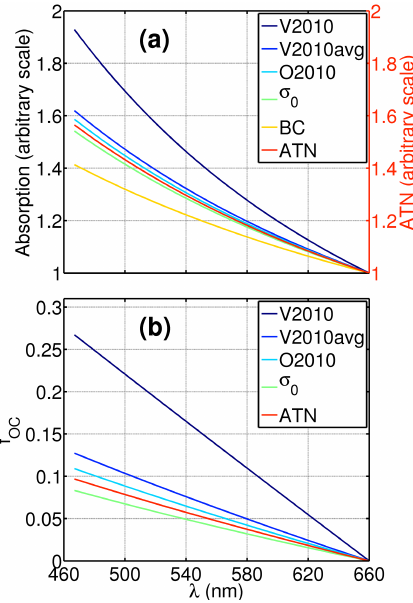
Figure 8. The difference in the wavelength dependency of absorp- tion using different approaches for deriving AAEs and their impact on the estimated fraction of absorption by OC ( f OC ). (a) The wave- length dependency of absorption and filter attenuation ATN calcu- lated using the AAEs of Table 1. At 660nm all absorption is at- tributed to BC with an AAE of unity. (b) The wavelength depen- dency of f OC which is the fraction of absorption that exceeds the absorption of BC from Eqs. (12a) and